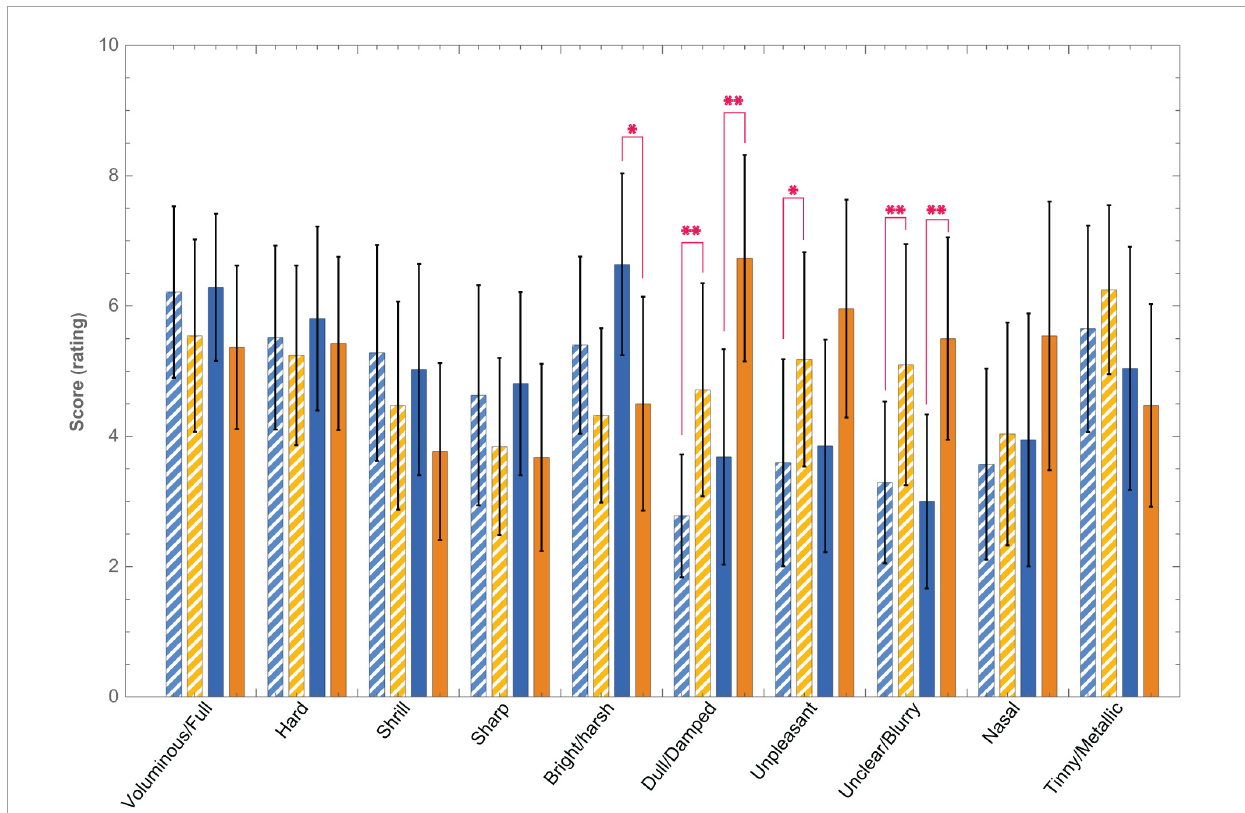
FIGURE8 Mean sound quality ratings of 10 features on a scale of 0 (not at all) to 10 (very) with the imaging-based (orange − ) and standard (blue − ) fitting at +3 weeks (dashed bars) and +12 weeks (solid bars). Asterisk (*) denotes p < 0.05 and double asterisk (**) denotes significant difference after applying Holm-Bonferroni correction. Error bars indicate 95% confidence intervals.